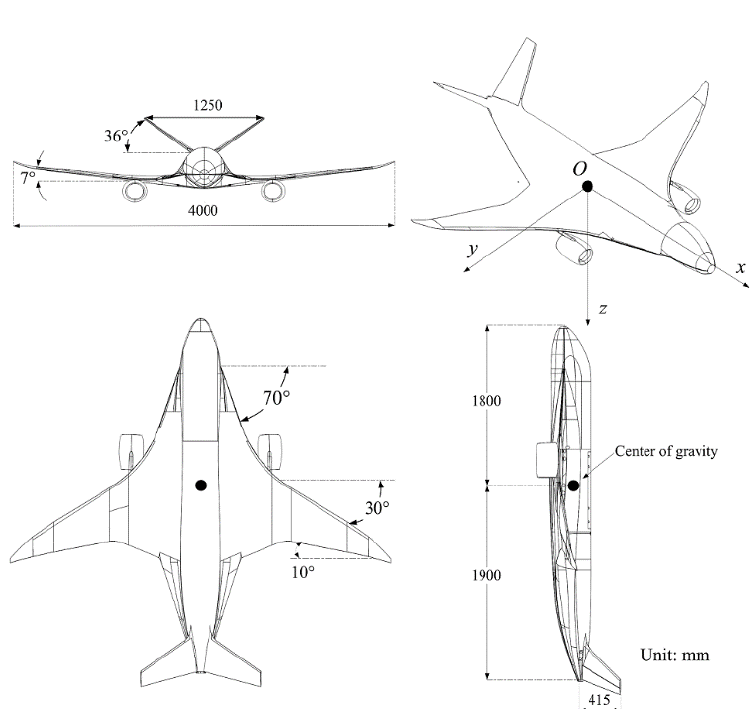
Figure 6. Layout of the test model.